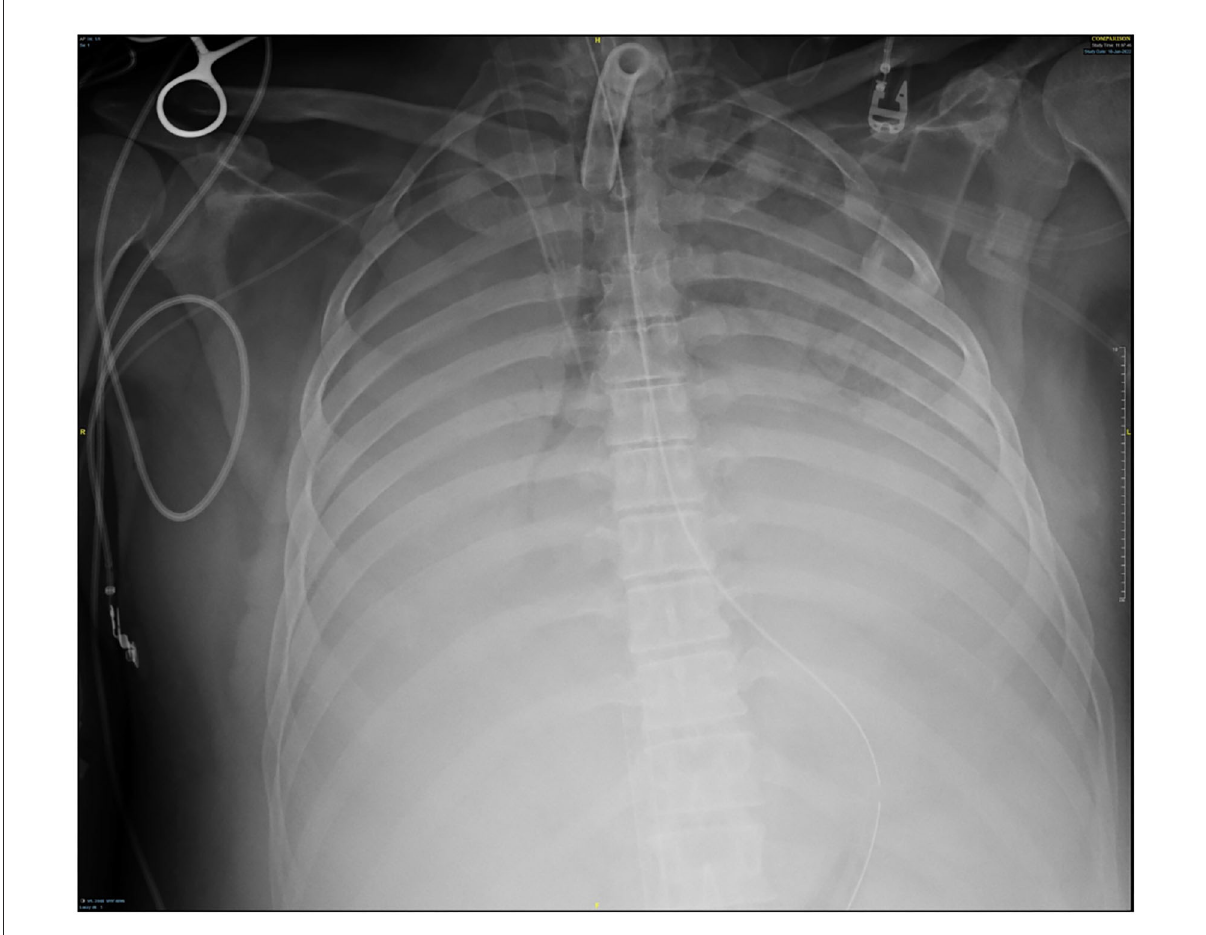
FIGURE5 Chest x-ray 2 days after resuming